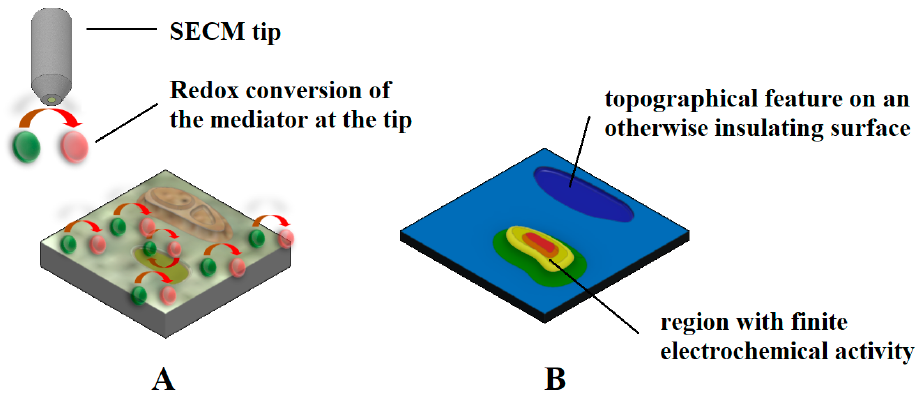
Figure 4. Sketches depicting: ( A ) the redox conversion of an electrochemical mediator at the am- perometric tip of SECM over a mostly insulating surface, whereas the redox mediator regeneration solely occurs in a region exhibiting electrochemical reactivity; and ( B ) the current measured at the tip, which contains information on the topography of the sample (i.e., blue color palette) eventually coupled with a region showing a heterogeneous chemical reactivity distribution (red and yellow color palette).